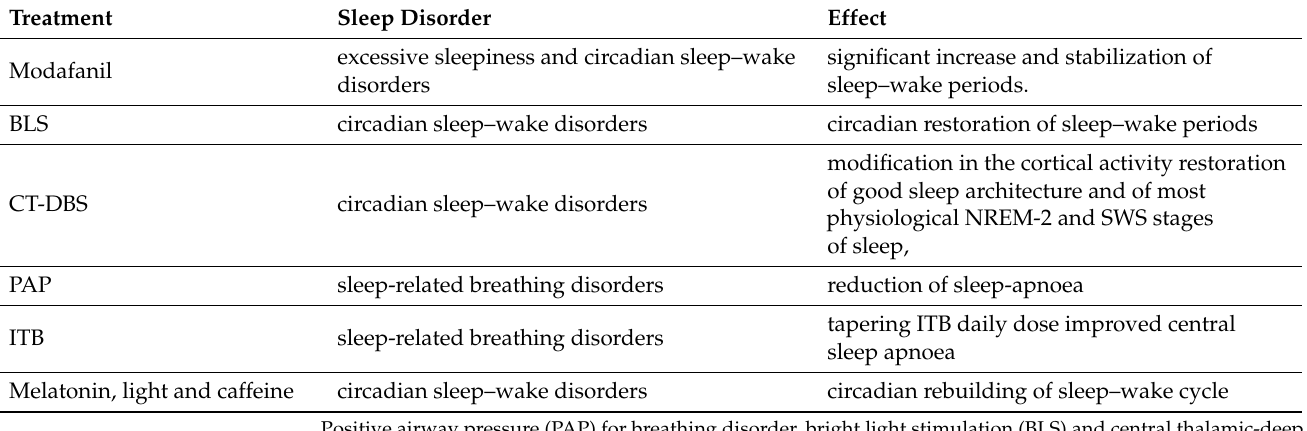
Table 1. Main pharmacological and non-pharmacological treatments for DOC sleep-related